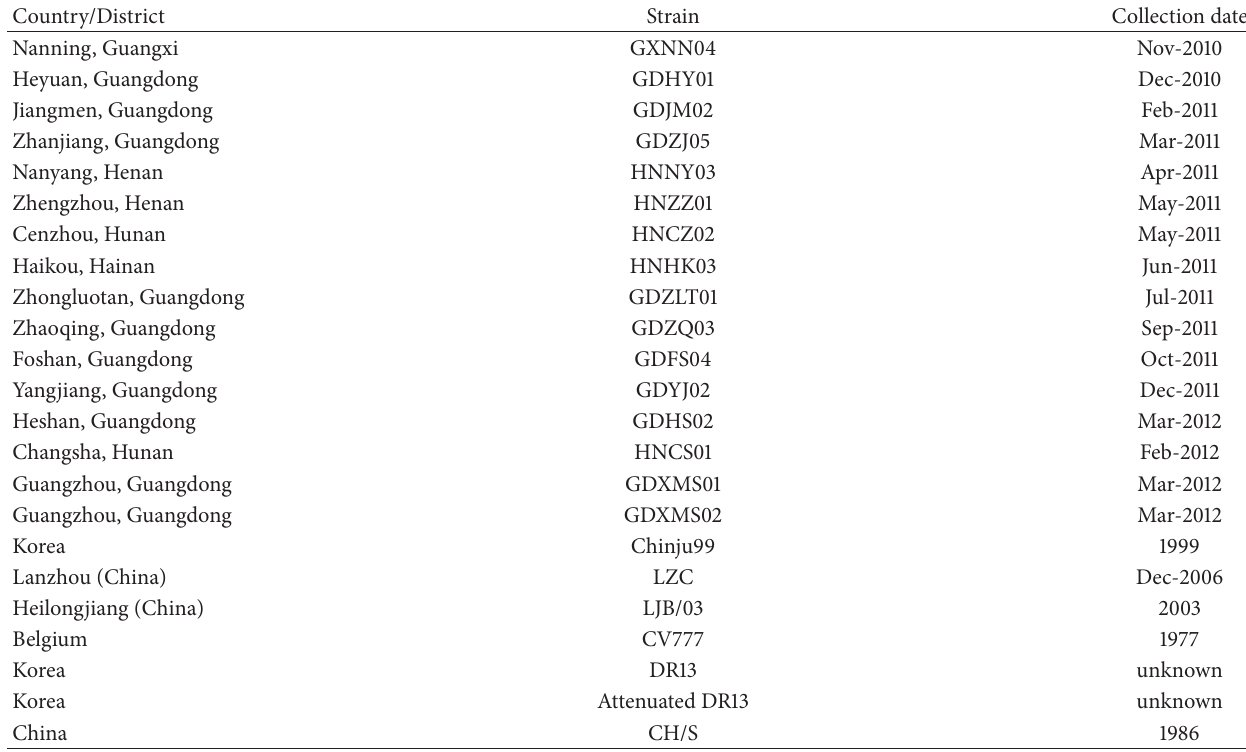
Table 1: Detail information of present and reference sequences used in Figures 1(a), 2(a), and 3(a) including country/district and collection